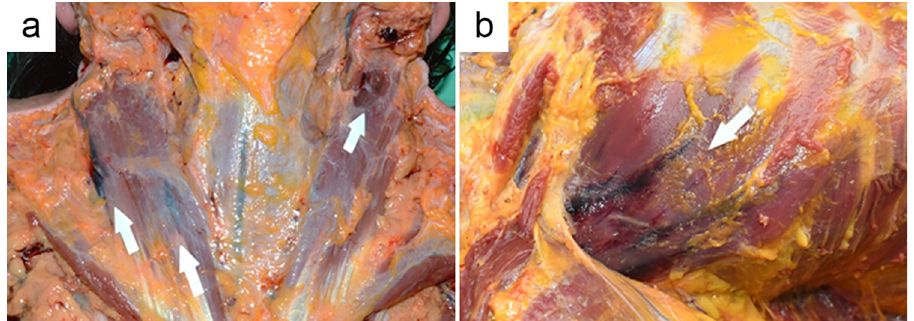
Fig 1. Representative photographs of intramuscular hemorrhage in accessory respiratory muscles obtained from study samples. (a) Sternocleidomastoid muscle of female in her late 60s. (b) Pectoralis minor muscle of male in his early 70s.